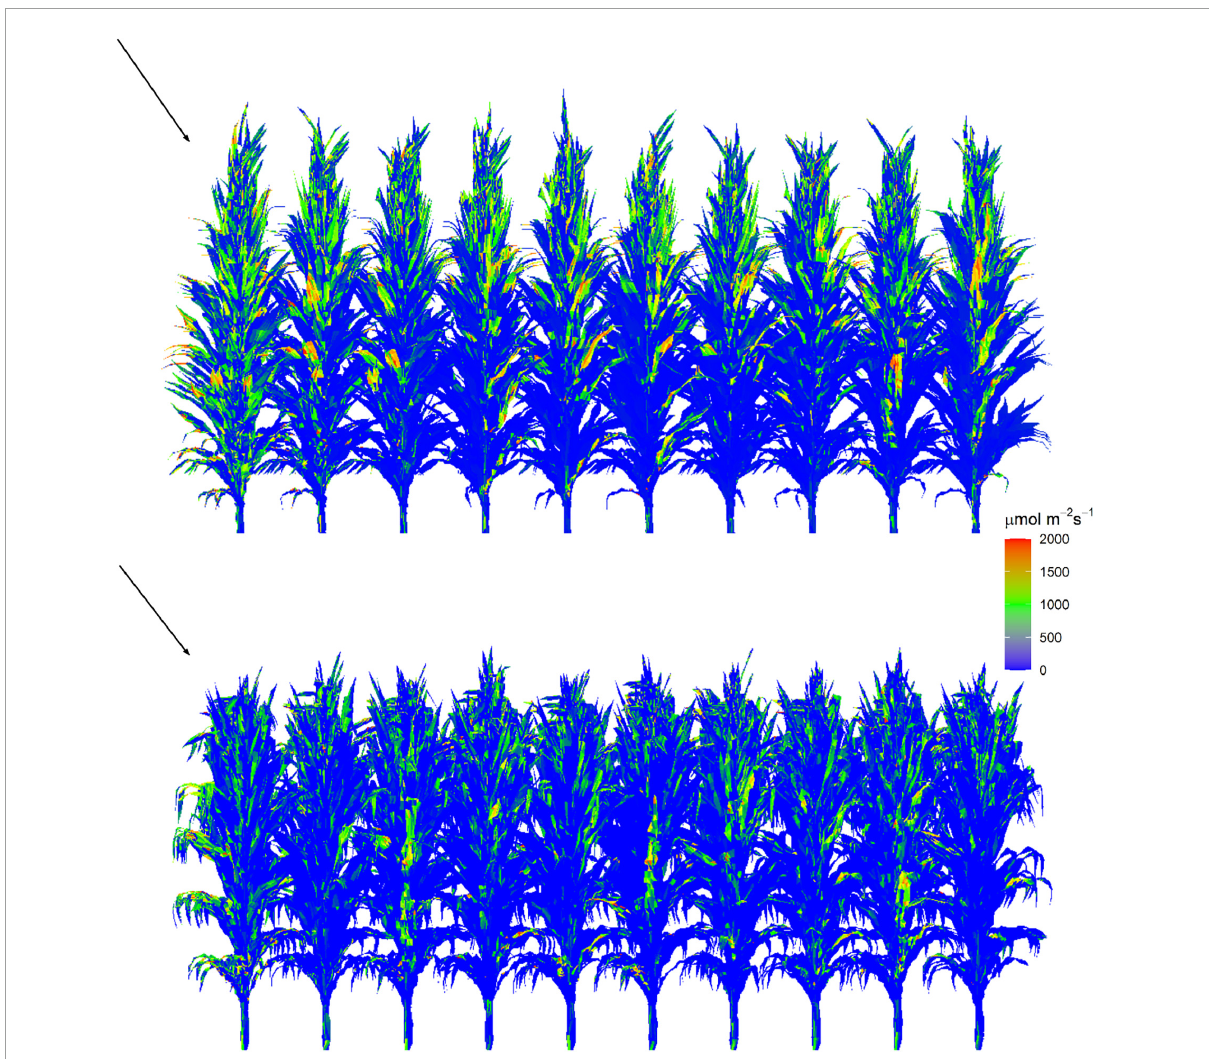
FIGURE3 Visualization of intercepted PAR by facets within reconstructed canopy at 12:00 on a clear day on August 1, 2019 for XY335 (top) and ZD958 (bottom) at the density of 7.5 plants m - 2 . Each canopy is composed of 200 plants with 10 rows and 20 plants per row. Red triangles represent higher values and blue triangles represent lower values. The arrow indicates the illumination direction and the sun elevation angle is 68 ◦